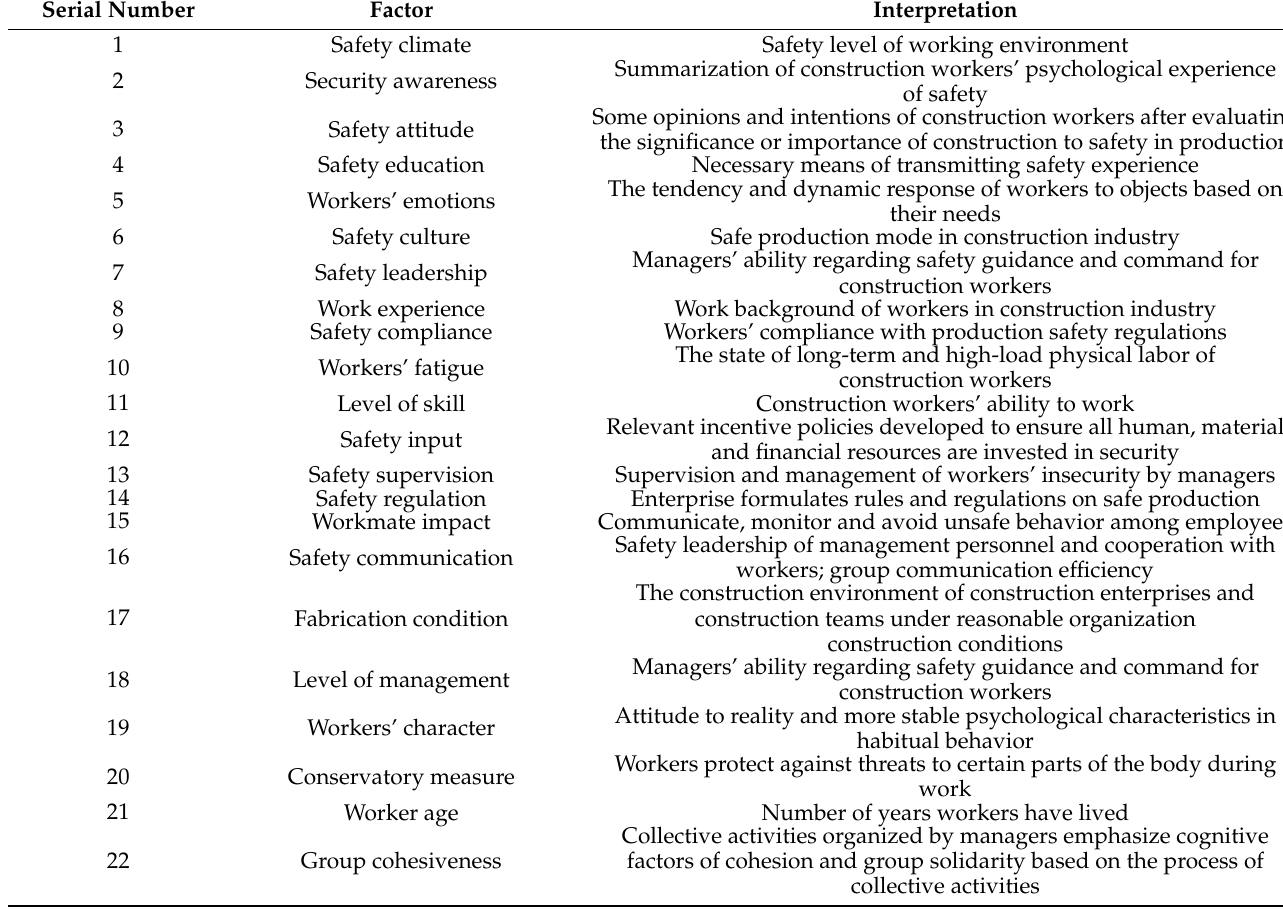
Table 2. Interpretation of high-frequency